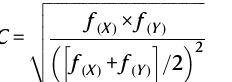
Table S8. Three parameters in our study are speci fi ed, including gaussian error distribution, a learning rate of 0.001, an interaction depth of 5, and a bag fraction of 0.5, as recommended 79,86 . All analyses are conducted with R (version 3.4.3), modeling with “ gbm ” package plus custom code that is available online 79